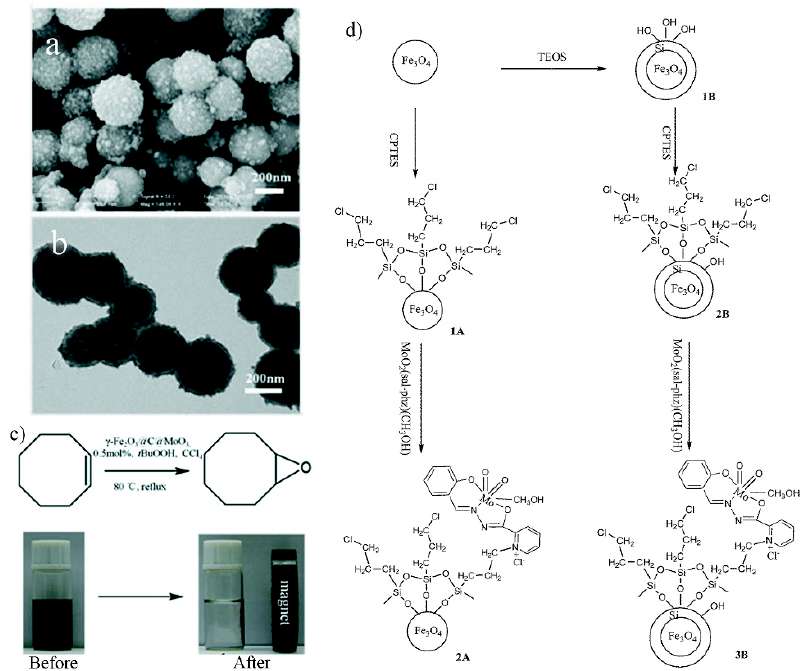
Figure 3. Scanning electron microscope (SEM) ( a ) and transmission electron microscope (TEM) ( b ) images of the as-prepared γ -Fe 2 O 3 @C@MoO 3 core/shell nanoparticles (NPs); ( c ) Photographs of reaction mixtures before and after magnetic separation. Reproduced with permission from reference [82]. Royal Society of Chemistry (2014). ( d ) Two synthetic pathways of preparing molybdenum Schiff base complexes modified Fe 3 O 4 . Reproduced with permission from reference [83]. Royal Society of Chemistry (2016).